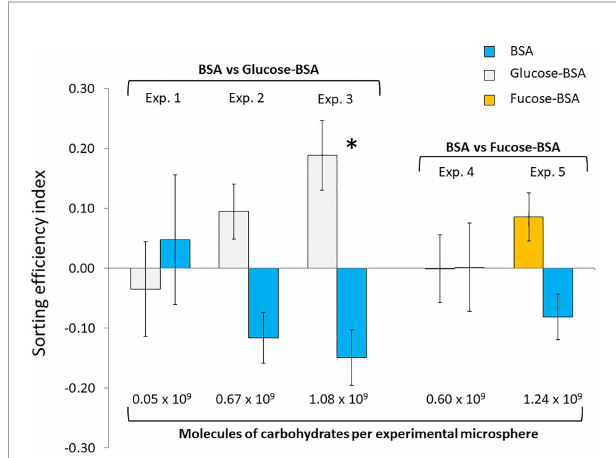
sorting ( Figure 5 ). In the fucose-BSA experiments (i.e., Exp. 4